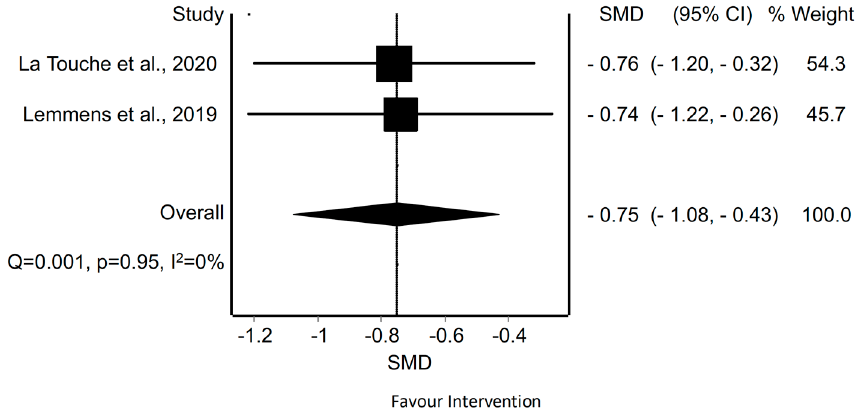
Figure 9. Synthesis forest plot for the frequency of symptoms in patients with migraine treated with aerobic exercise. The forest plot summarizes the results of included studies (review size, standardized mean differences [SMDs, and weight). The small boxes with the squares represent the point estimate of the effect size and sample size. The lines on either side of the box represent a 95% confidence interval (CI).